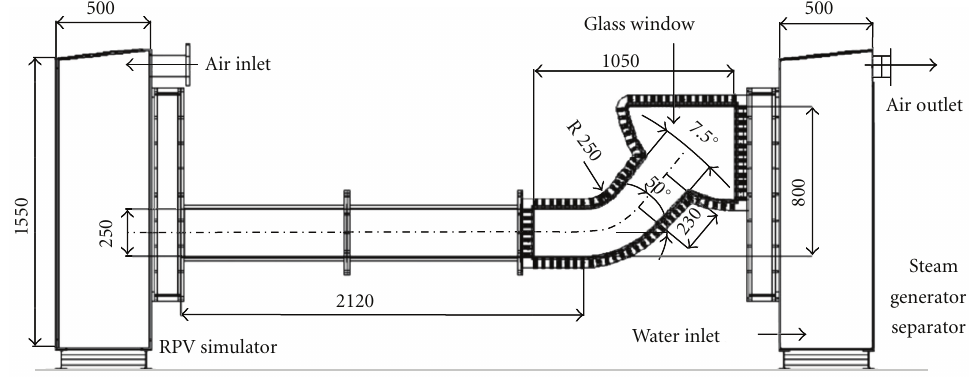
Figure 2: Schematic view of the hot leg model test section (dimension in mm).